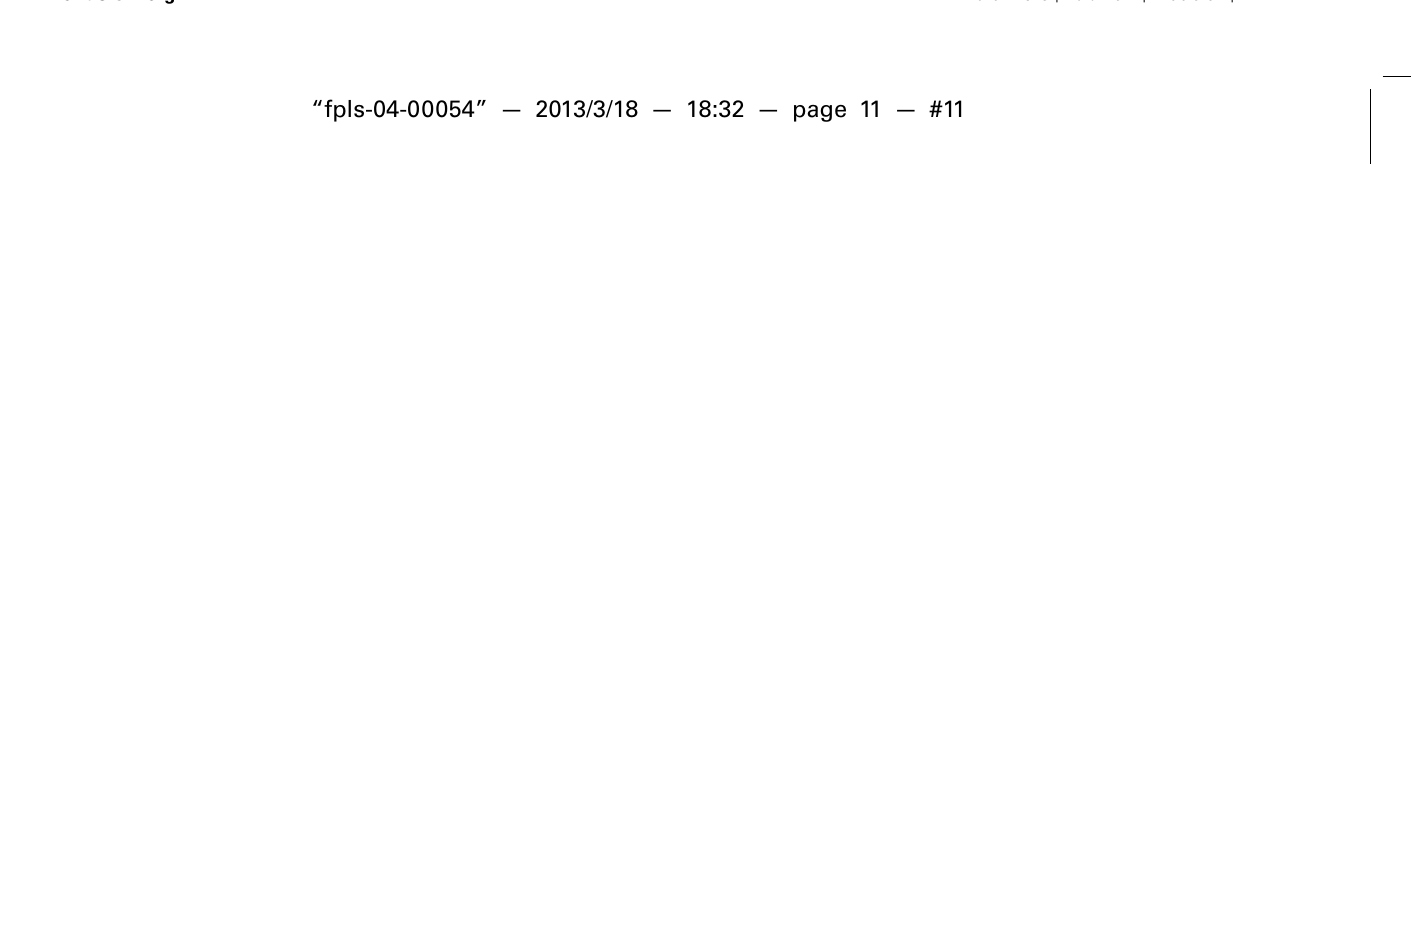
presence of NEM to block free thiols, then reduced with DTT, and finally labeled with biotin maleimide. (B) The same samples were probed with 2-Cys Prx antibody to determine the redox state of 2-Cys Prx.The oxidized dimer and reduced monomers are indicated.